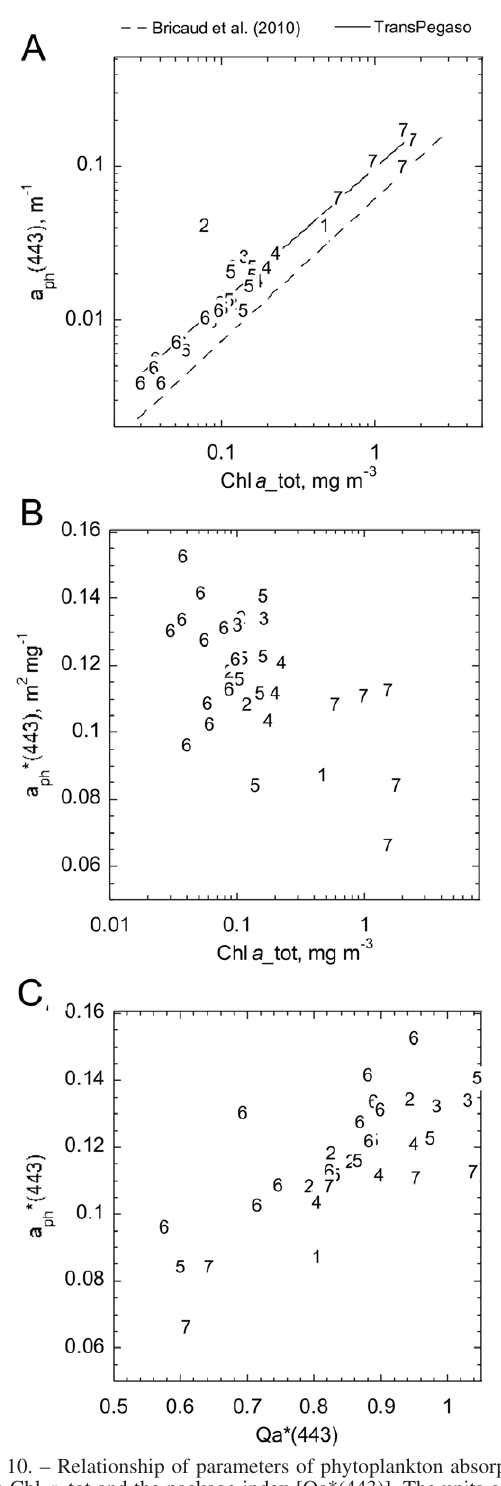
Fig. 10. – Relationship of parameters of phytoplankton absorption with Chl a _tot and the package index [Qa*(443)]. The units of the variables are mg m –3 for Chl a _tot, m –1 for a (443) and a (443), ph pig and m 2 mg –1 for a *(443). The numbers within the graph indicate ph the provinces (see the explanation of Figure 1 for abbreviations): 1, MEDI; 2, NAST-E; 3, CNRY; 4, NATR; 5, WTRA; 6, SATL; 7, SWAS. A, power regression of a (443) on Chl a _tot; the equa- ph tions for TransPEGASO are a (443)=0.098*Chl a _tot^0.88, ph r 2 =0.93, and those for Bricaud et al. (2010) are a (440)=0.0617*Chl ph a _tot^0:93. B, relationship between a *(443) and Chl a _tot. C, ph relationship between a *(443) and Qa*(443). Number codes as in ph Figure 2.